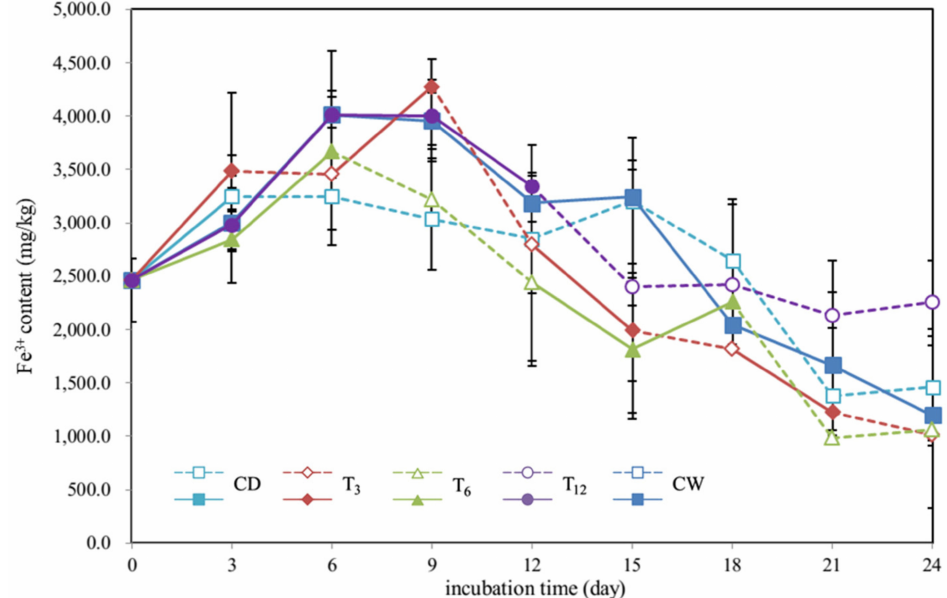
Figure 6. The dynamic of Fe 3+ content in different treatments. The solid and dotted lines represent the rewetting and drying period, respectively. The vertical bars refer to one standard deviation ( n =